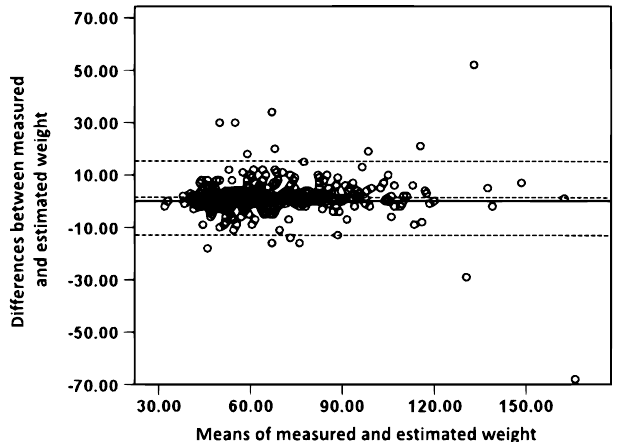
Figure 1. Bland and Altman levels of agreement plot for the measured and estimated body weight. The centered dotted line represents the mean differences or bias (1.26 kg) and the outer doted lines represent the upper (14.2 kg) and lower (− 11.7 kg) 95% of limits of agreement.